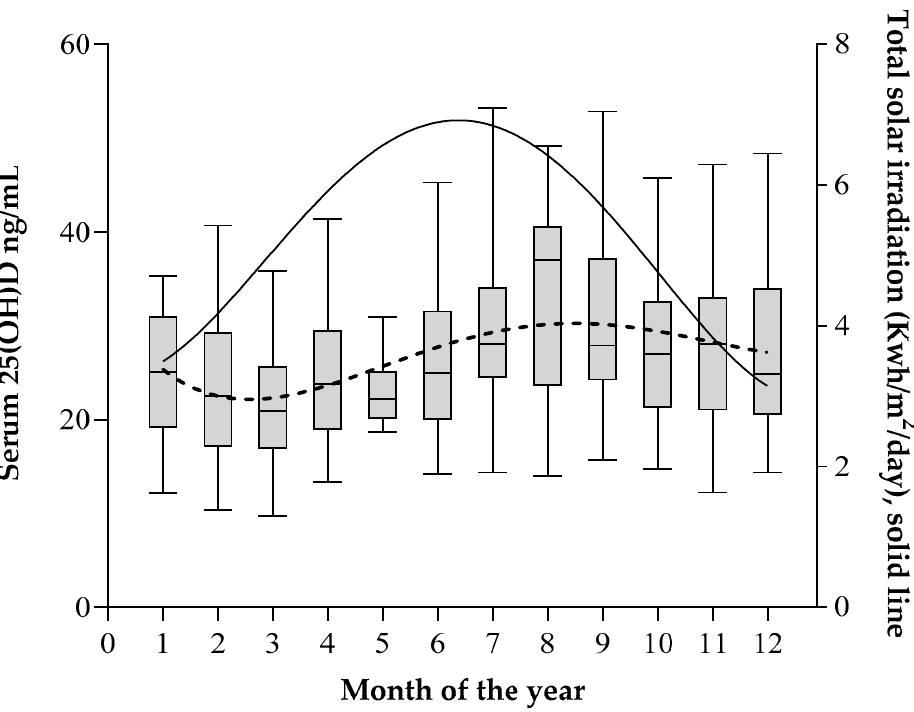
Figure 2. Box plot graph showing the serum 25(OH)D levels during the different months of the year. The values represent medians (horizontal line), interquartile ranges (box) and P5 and P95 percentile (whiskers). The solid line represents the variation of mean total solar irradiation in the Canary Islands during the time frame of the study.